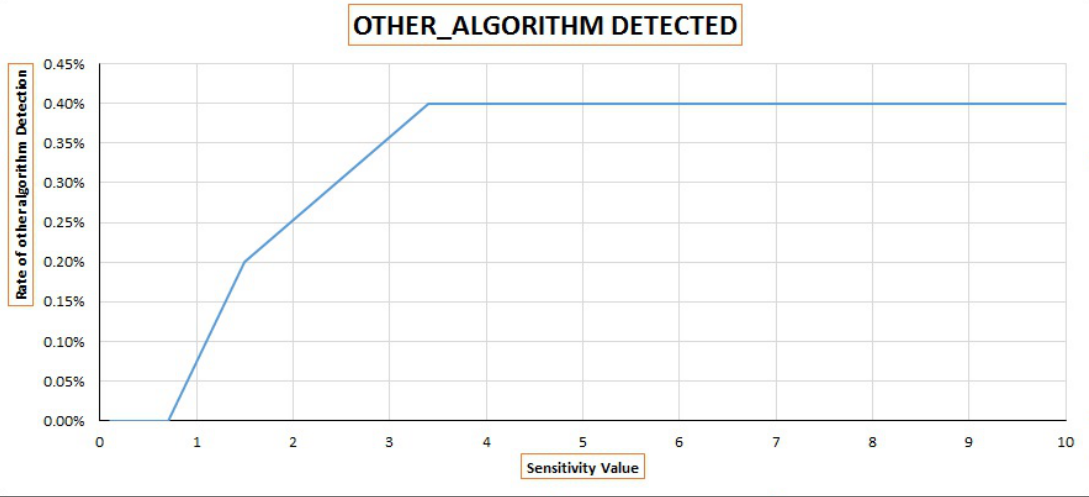
Figure 6. Changes in other algorithms detected with different